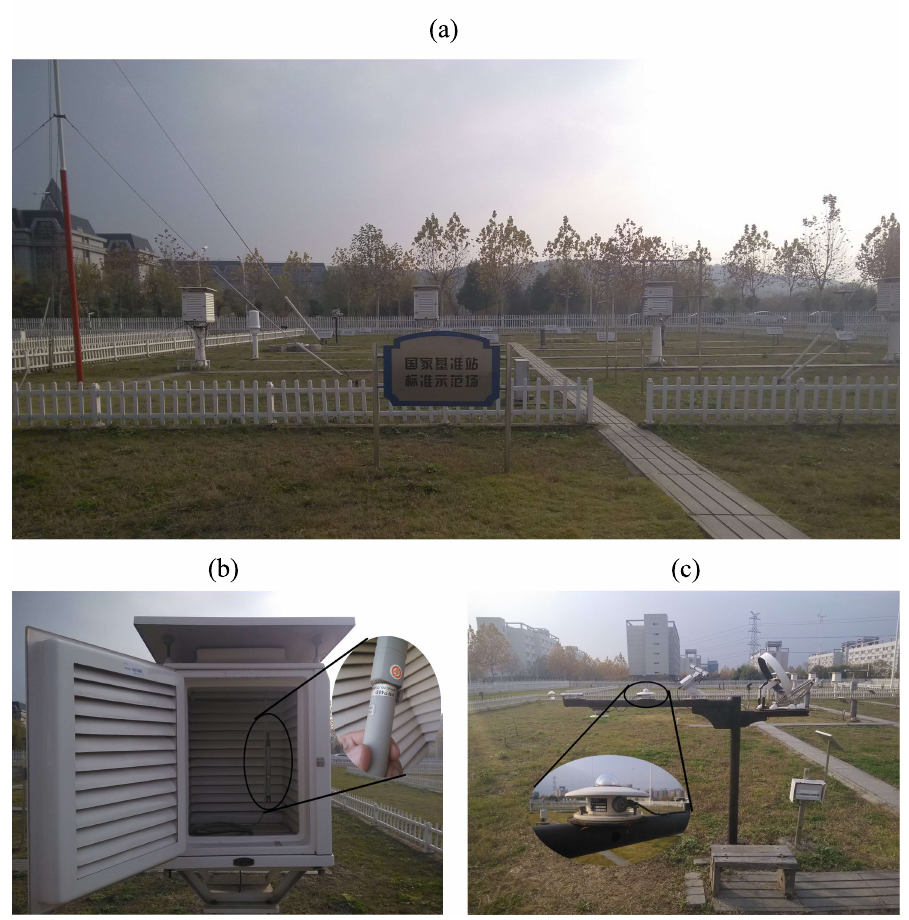
Figure 6. National weather station at NUIST, China, No. 59606. ( a ) Panorama of the AWS; ( b ) the meteorological temperature sensor (HMP45D) in the thermometer screen in the AWS; ( c ) the pyranometer (TBQ-2-B) in the